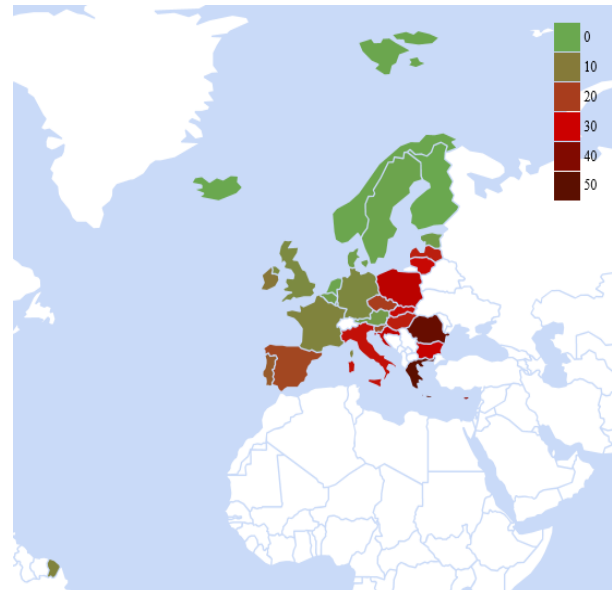
Figure 1: Average forecasted AMR’s percentage for all analyzed microbial species in 2020